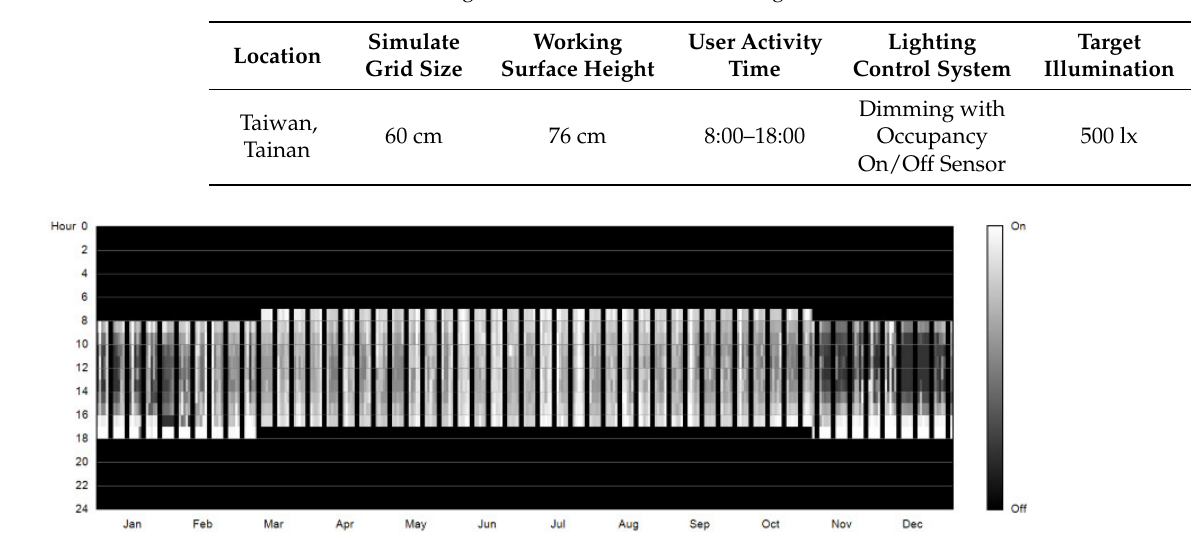
Figure 8. Lighting schedule setting simulated by DIVA (WWR = 30%, laminated clear glass, perforated ratio of expanded metal mesh = 21%).